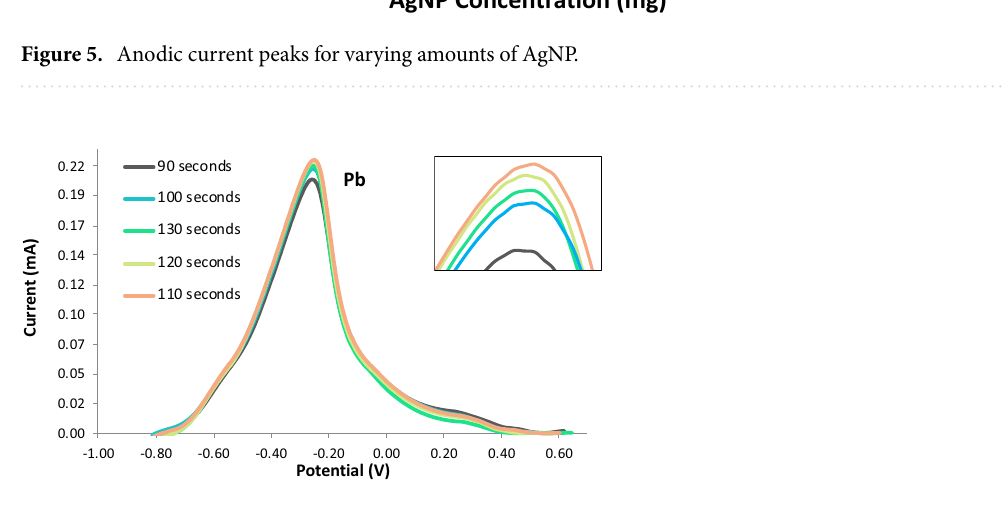
Figure 6. Voltammograms for varying deposition